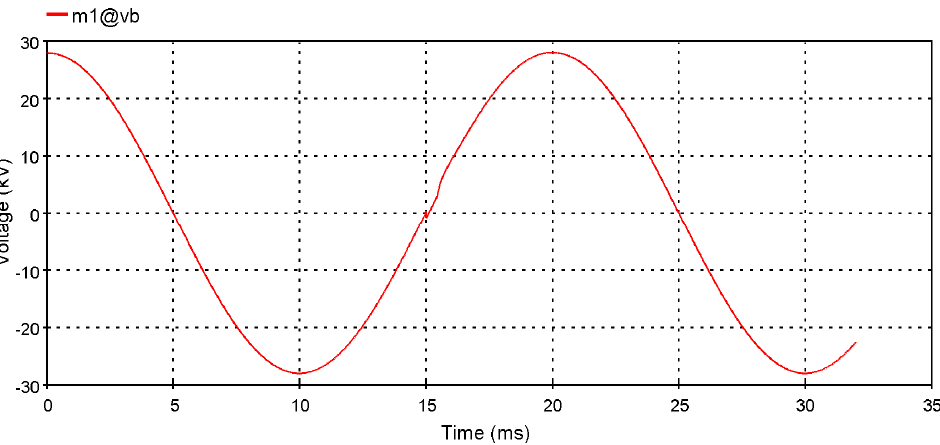
Figure 13. Limited overvoltage at the secondary side of the main power transformer with SPD ideally connected.